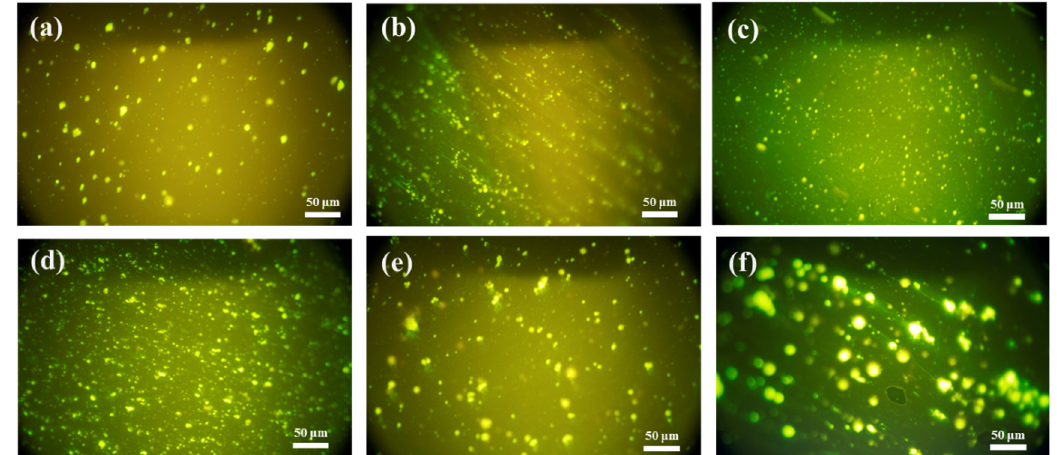
Figure 16. Morphology of tested samples (×400). ( a ) A2P0; ( b ) A2P1.0; ( c ) A2P1.5; ( d ) A2P2.0; ( e ) A4P1.5; and ( f ) A6P1.5.